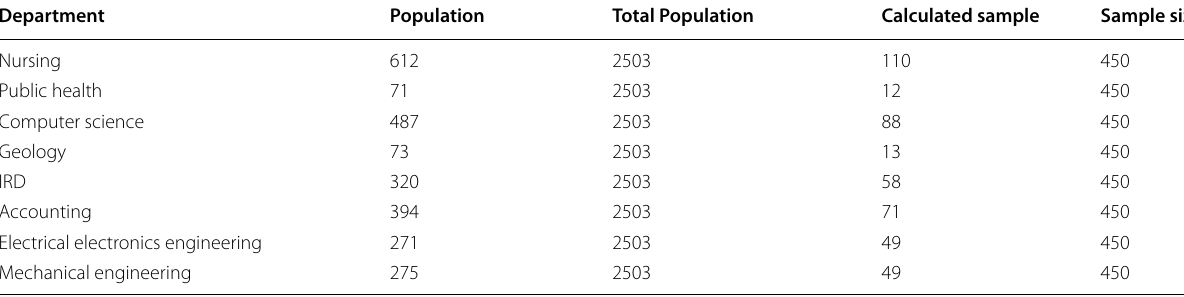
Table 1 Sample proportion allocation of students based on